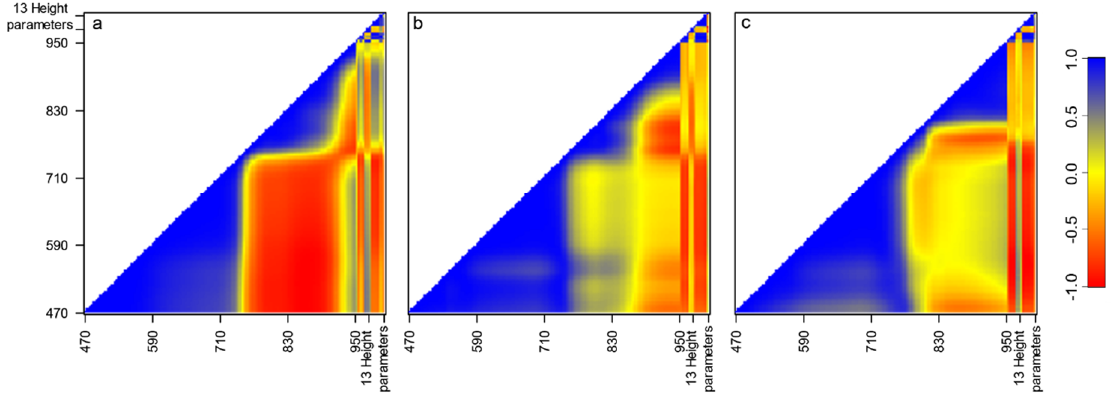
Figure 3. Intercorrelation between all explanatory variables (i.e., 120 spectral bands and 13 height parameters) for ( a ) eggplant, ( b ) tomato, and ( c ) cabbage.